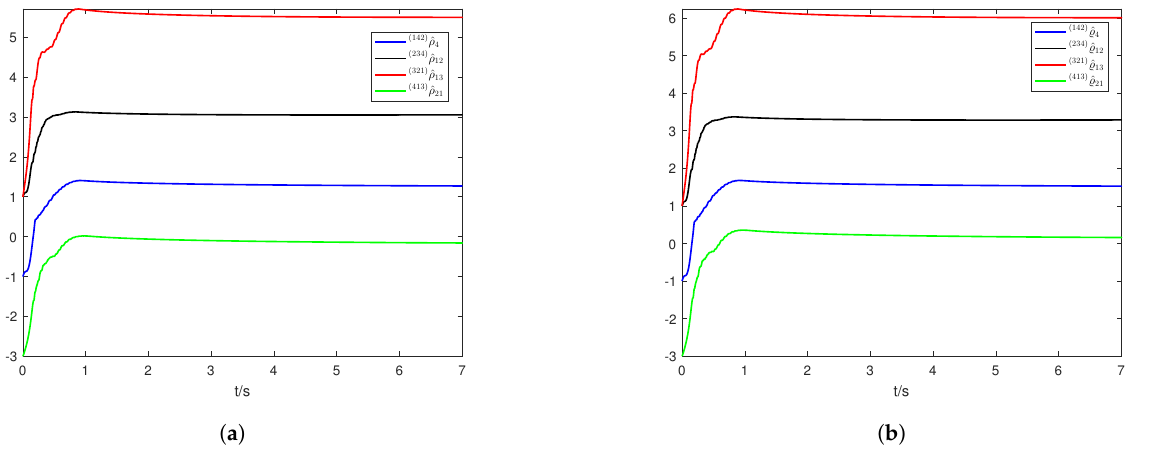
Figure 14. The estimation of parameters ( 142 ) ˆ ρ 4 , ( 234 ) ˆ ρ 12 , ( 321 ) ˆ ρ 13 , ( 413 ) ˆ ρ 21 and ( 142 ) ˆ (cid:36) 4 , ( 234 ) ˆ (cid:36) 12 , ( 321 ) ˆ (cid:36) 13 , ( 413 ) ˆ (cid:36) 21 shown in sub-pictures ( a , b